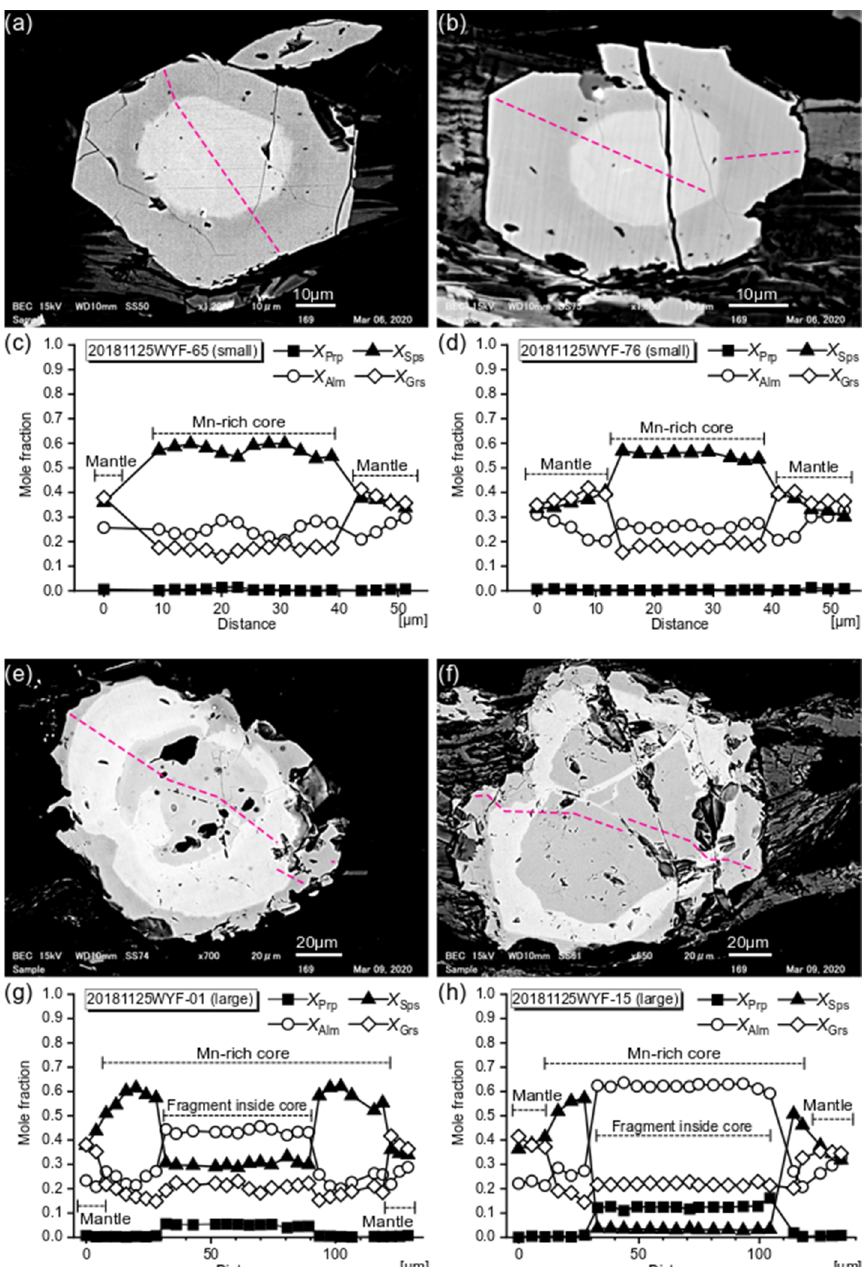
Figure 5. Backscattered electron images (BEIs) of garnet grains in one thin section together with the compositional profile obtained by semi-quantitative energy-dispersive X-ray spectroscopy (EDS) analyses. Pink dotted lines on BEIs show where line analyses were performed. Sample no. 20181125WYF. ( a ) and ( b ): BEIs of grains No. 65 and No. 76, respectively, which are presumably the smaller garnet grains that show log-normal crystal size distribution. ( c ) and ( d ): compositional profile of grains shown in ( a ) and ( b ). ( e ) and ( f ): BEIs of grains No.01 and No.15, respectively, which are exceptionally large concerning the log-normal crystal size distribution (see text). ( g ) and ( h ): compositional profile of grains shown in ( e ) and ( f ).